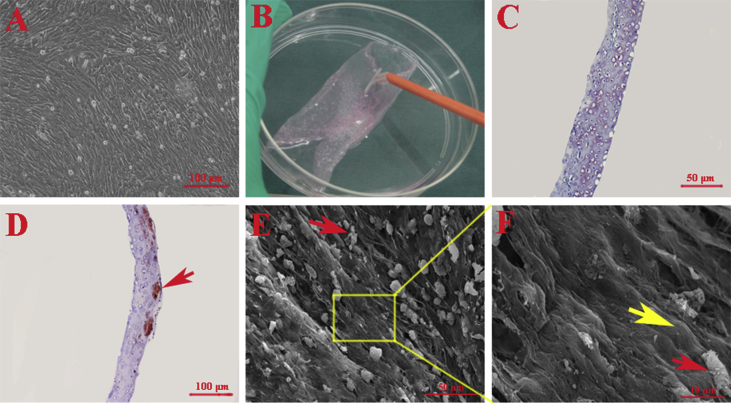
Characterization of BMSC sheets. (A) The cultured rabbit cells had a fibroblast-like morphology and grew well with a close arrangement (scale bar = 100 μm). (B) After the BMSCs were continuously cultured in osteogenic medium for 2 weeks, multiple layers of BMSCs formed a thick cell sheet that was easily lifted from the culture dish with a cell scraper and maintained intact. (C) Histological analysis demonstrated that the obtained sheet consisted of several layers of cells that secreted autologous ECM (scale bar = 50 μm). (D) Alizarin red staining further verified that calcium deposits (red arrow) formed throughout the cell sheet (scale bar = 100 μm). (E) SEM analysis also showed obvious mineral-like nodules (red arrow) on the surface of the cell sheets (scale bar = 50 μm). (F) High-magnification SEM images showed that BMSCs were trapped and embedded within autologous secreted ECM (yellow arrow); the red arrow indicates mineral-like nodules (scale bar = 10 μm).